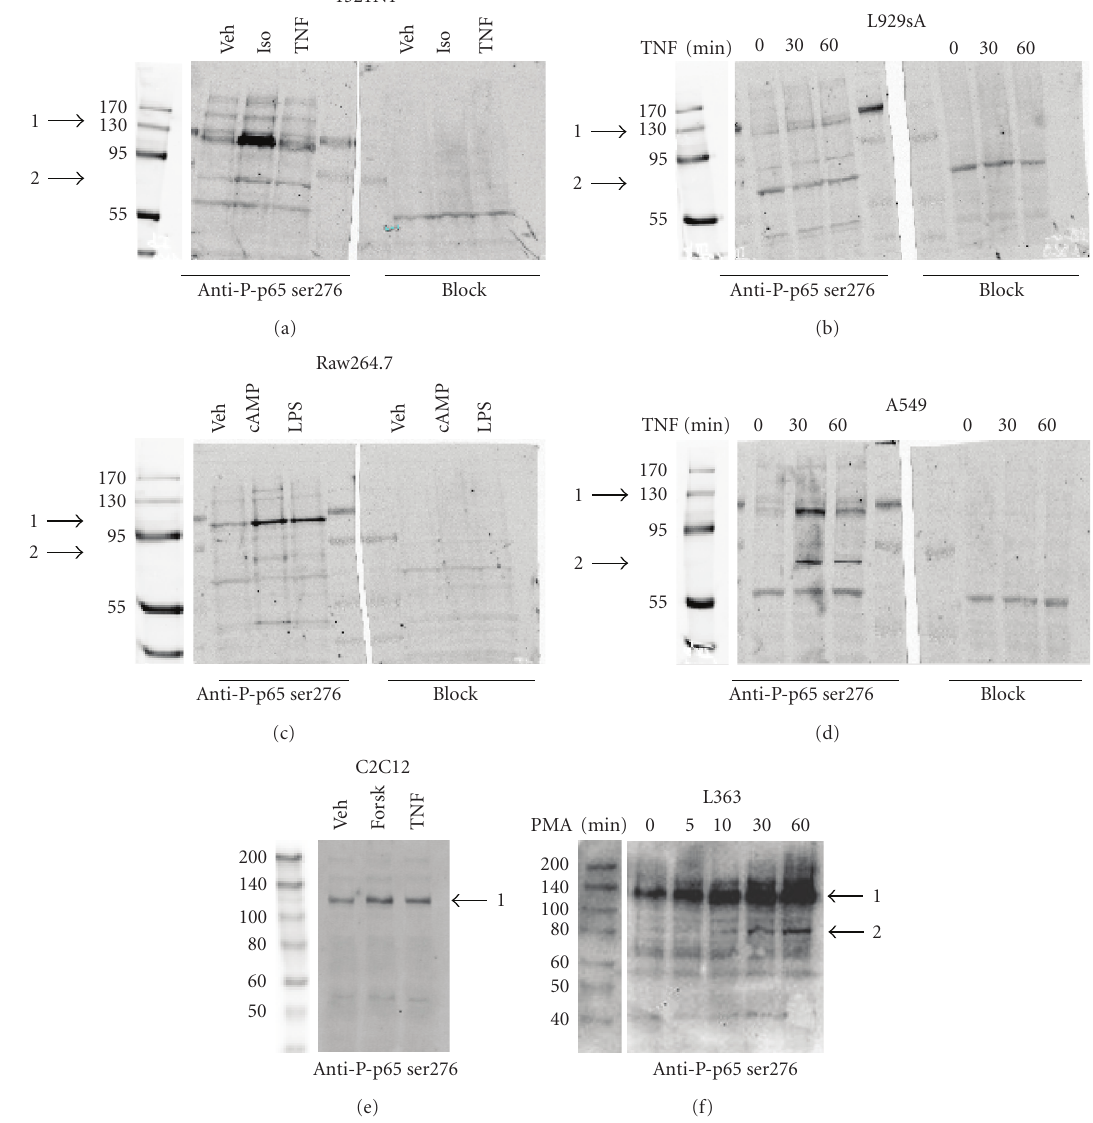
Figure 1: Anti-phospho-p65 Ser276 (Cell Signaling no. 3037) detects atypical (with MWs of 80 and 130 kDa), inducible immunoreactivities in di ff erent cell types, induced with di ff erent NF- κ B-activating agents. Cells were stimulated for increasing times (L929sA, A549, L363) or for 30min (Raw264.7, C2C12, 1321N1) with TNF- α (2000 IU/mL), LPS (1 μ g/mL), PMA (10ng/mL), forskolin (forsk, 10 μ M) or isoproterenol (iso, 10 μ M). For blocking experiments, lysates were loaded on one gel in duplicate and after transfer, blots were cut in half. Immunodetection was performed in parallel, using Cell Signaling no. 3037 or Cell Signaling no. 3037 preincubated for at least 30 minutes with double volume of blocking peptide (BLOCK). Arrow 1 indicates an immunoreactive band with an MW of 130kDa; arrow 2 indicates an immunoreactive band of 80